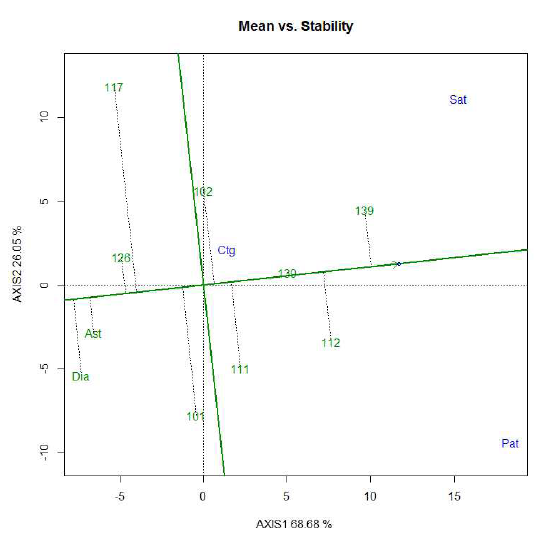
Figure 5: Ranking the test environments relative to the highest yielding genotypes at 3 locations during 2012-13 (Ctg=Chittagong, Pat=Patuakhali and Sat= Satkhira)